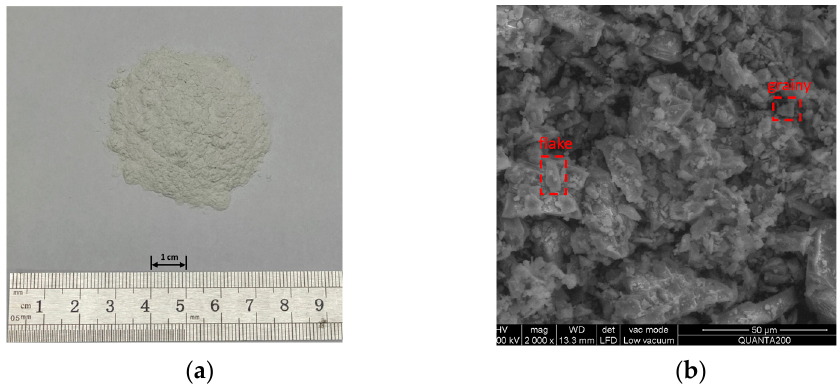
Figure 5. Mineral powder: ( a ) appearance, and ( b ) ESEM image of the mineral powder.